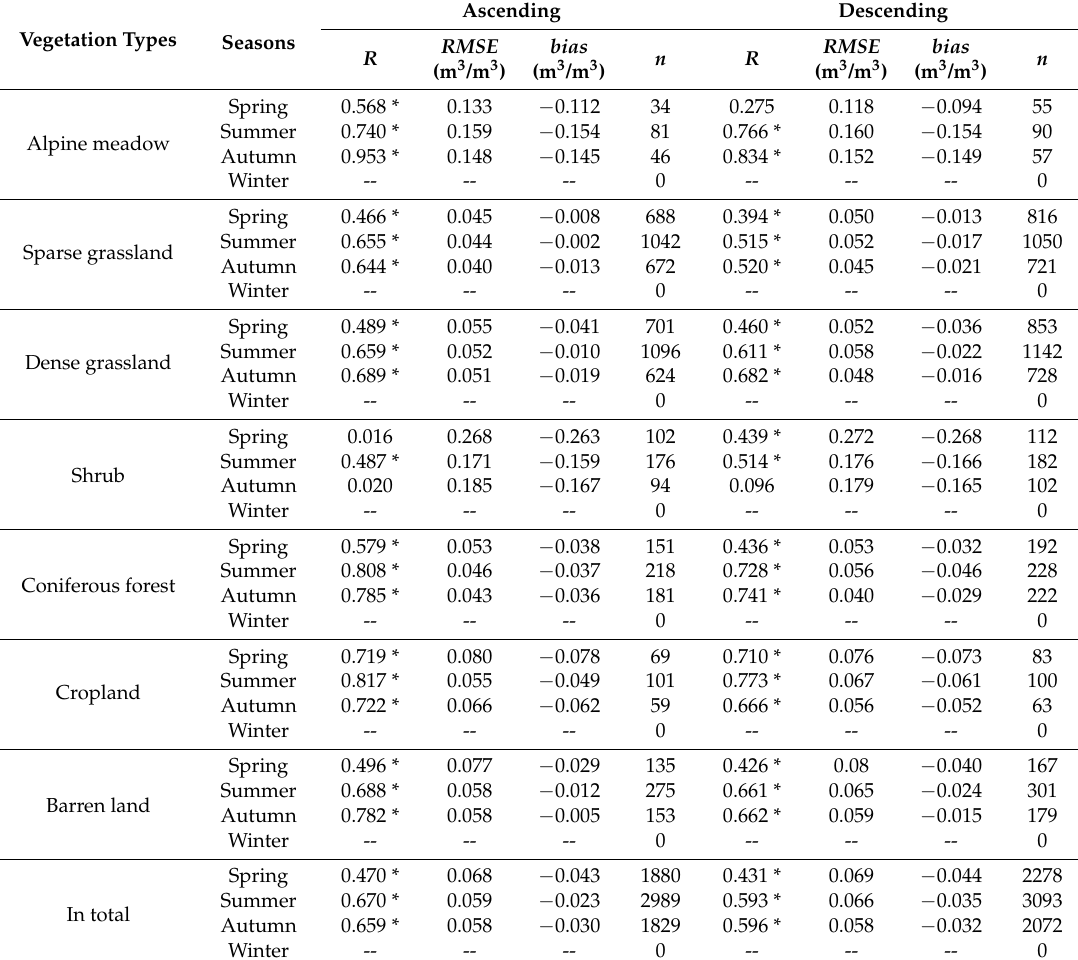
Table 6. Evaluation of the SMAP L3 products of both ascending and descending orbits at seasonal scale.